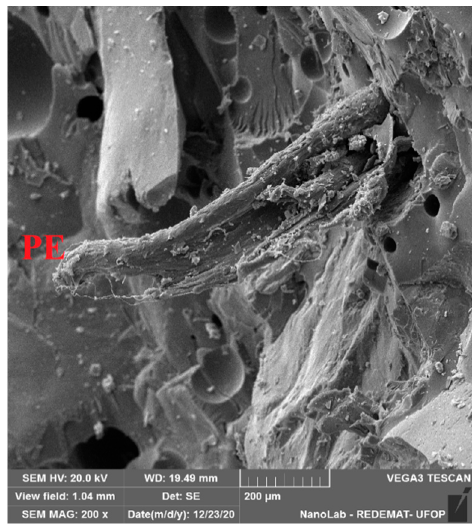
Figure 9. SEM-SE micrographs of the Composition 5—PE: PE waste.